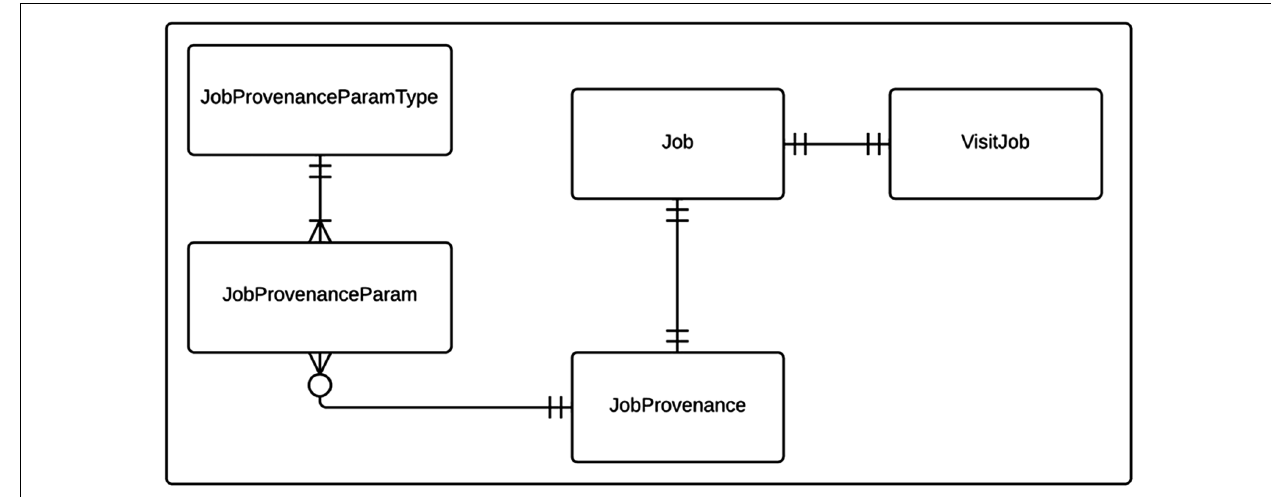
FIGURE 1 | Entity relationship (ER) diagram of CBFBIRN processing workflow data model. The relationships between the entities (database tables) including cardinality information are further explained in the text.